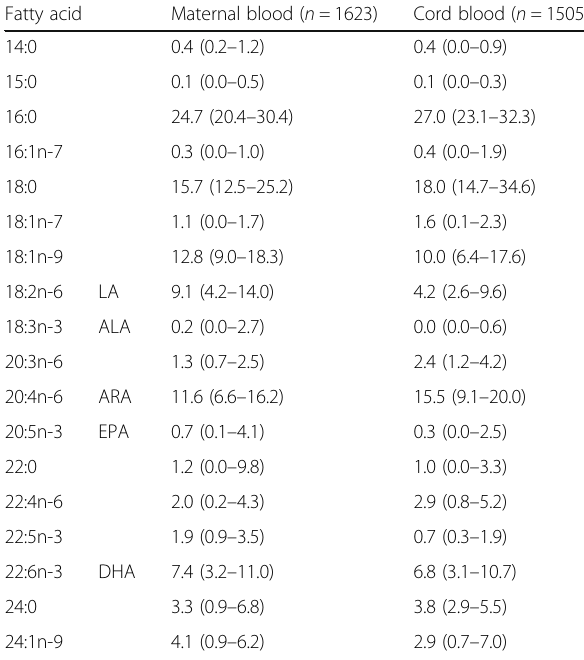
Table 2 Percentages by weight of fatty acid in maternal